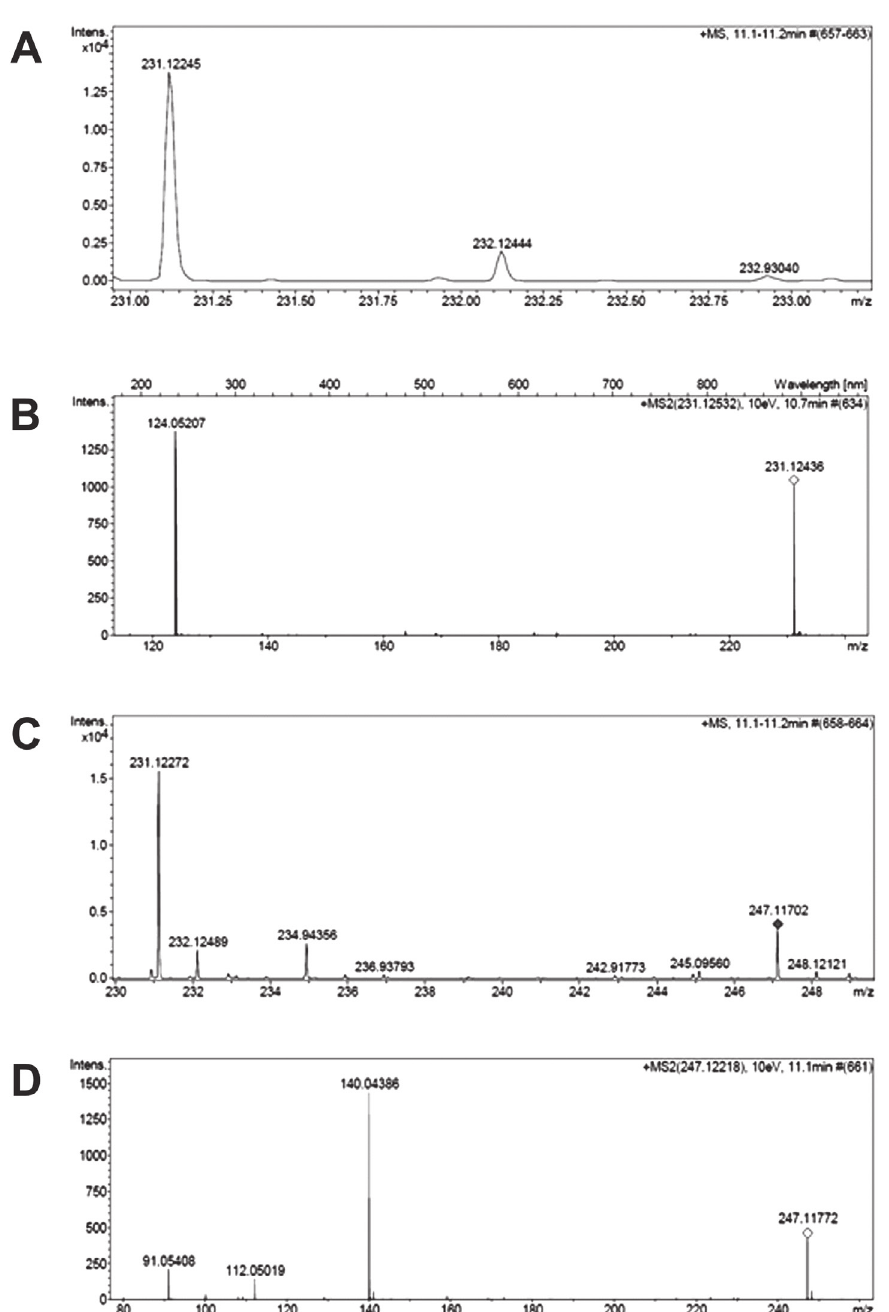
FIGURE 2 - A Amine-BNZ(H) + MS detection (m/z 231.12245; Retention time 10.7 minutes), scanning 50 to 800 m/z; B +MS2 for m/z 231.12532 and Retention time of 10.7 minutes; C N-hydroxi-amine-BZN(H) + MS detection (m/z 247.11702; Retention time 11.1-11.2 min), scanning 50 to 800 m/z; D +MS2 for m/z 247.12218 and Retention time of 11.1